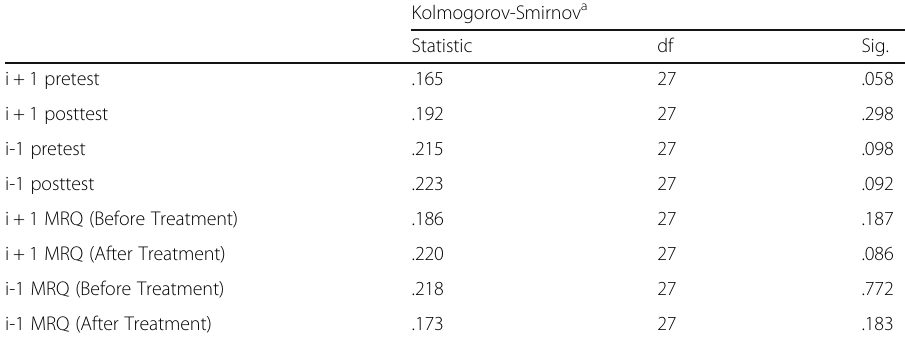
Table 3 One-Sample Kolmogorov-Smirnov Test (Groups ’ Pretests, Post-tests, and MRQ) Kolmogorov-Smirnov a Statistic df